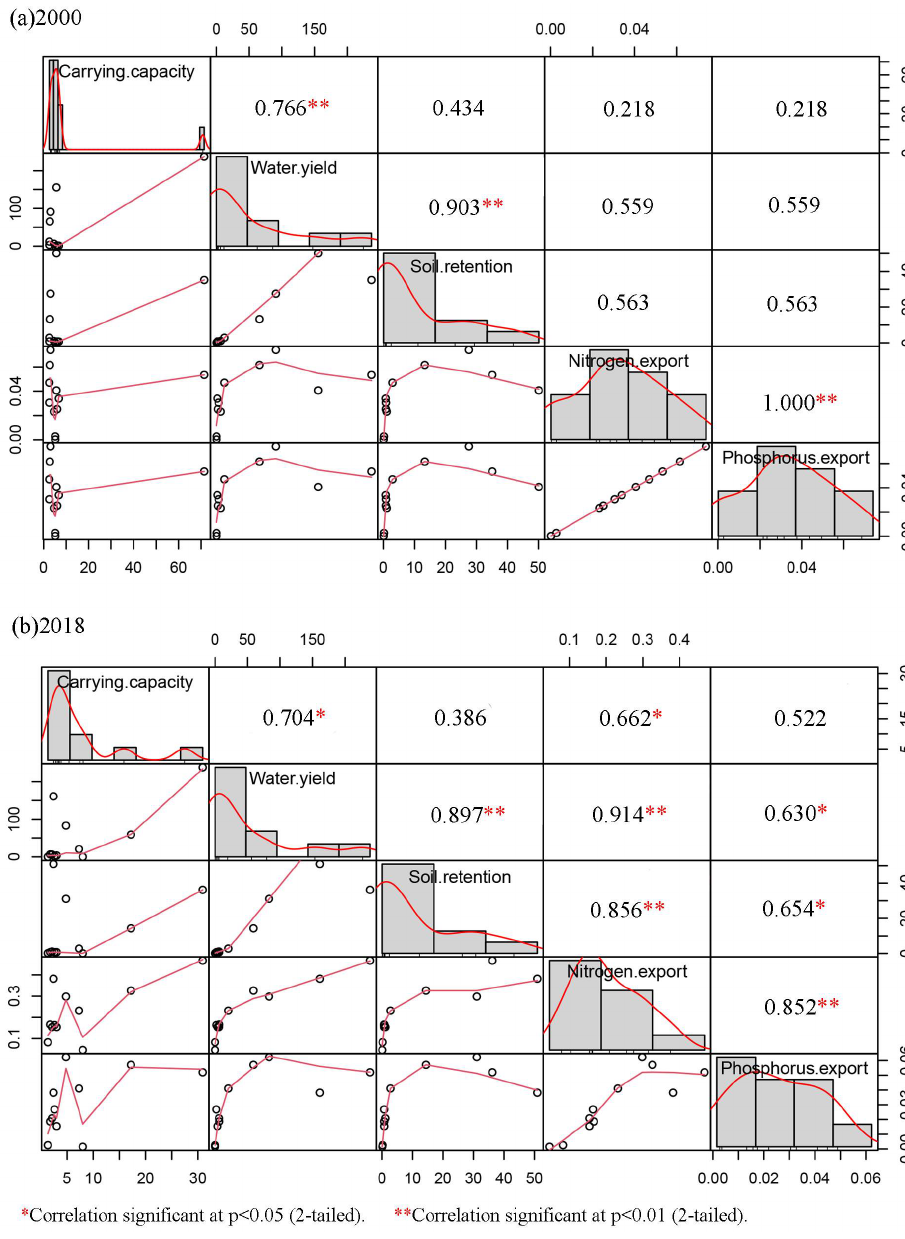
Figure 12. Pearson correlation coefficient (R 2 ) between carrying capacity and ecosystem services in HRB in ( a ) 2000 and ( b ) 2018.